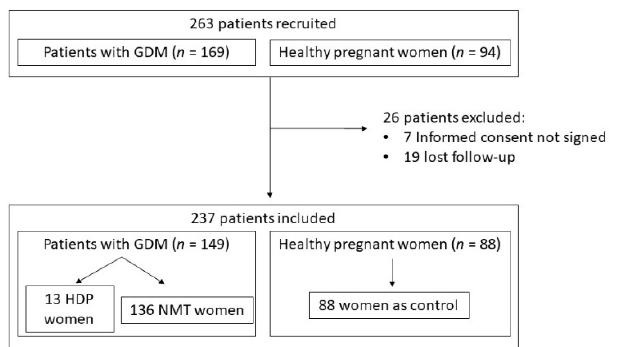
Figure 1. Study flow chart: algorithm for the identification of eligible women and number of women for each step of the procedure. GDM: gestational diabetes mellitus; HDP: hypertensive disorders of pregnancy; NMT: normotensive. Table 1. Demographic, clinical, and laboratory variables at the time of inclusion.